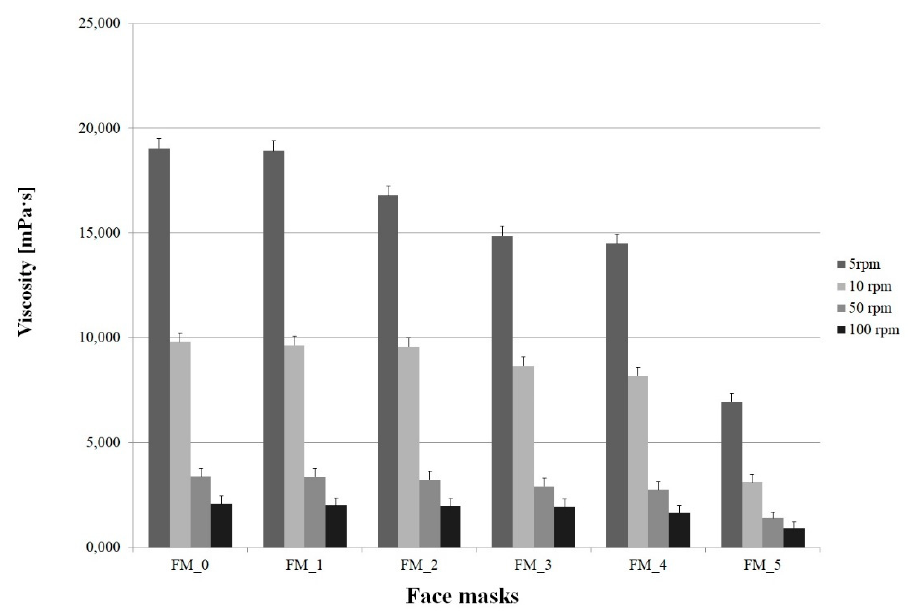
Figure 1. Dynamic viscosity of face masks with different concentrations of Lonicera Caerulea Fruit Powder.